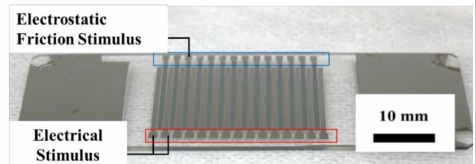
Figure 5. Depiction of the fabricated tactile display.